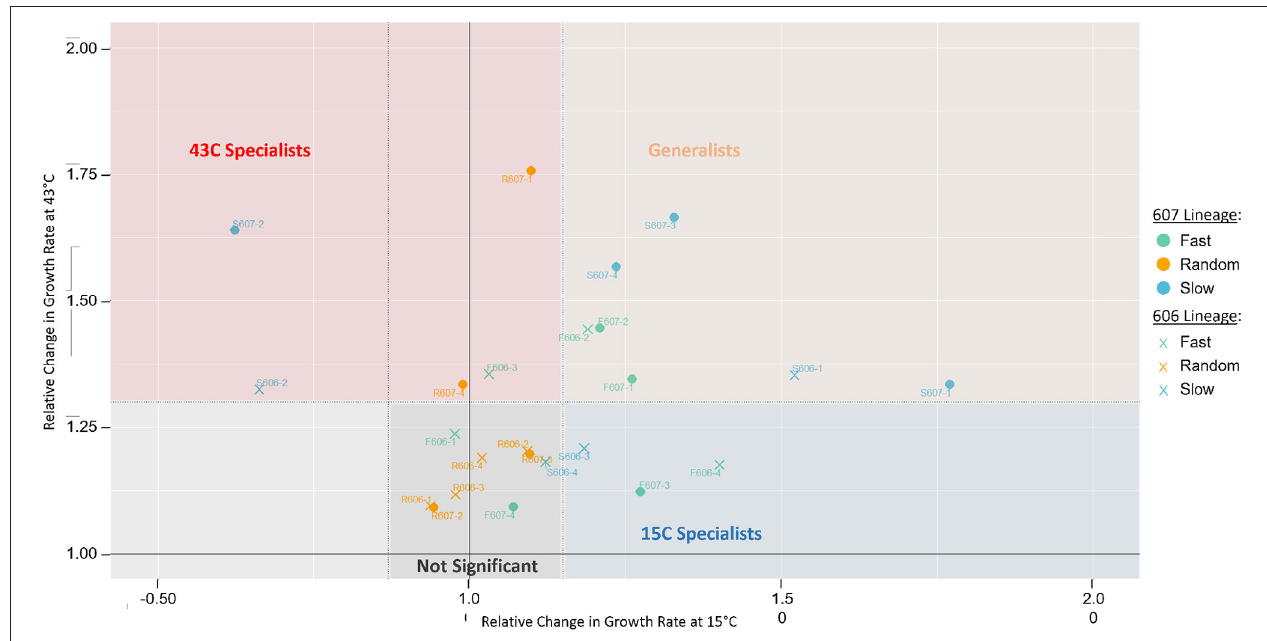
FIGURE 2 | Growth rate changes of isolated clones from the final populations relative to their starting strain, 606P or 607P. The y-axis represents the relative change in growth rates of the evolved clones compared to their respective starting strain at 43 ◦ C. The x-axis represents the relative change in growth rates at 15 ◦ C. For each temperature, statistical significance between the clonal strains and their corresponding reference strain was assessed by a two-sample T -test with a pooled sample variance using all the strains at the same temperature. The dotted lines represent the statistically significant cut-offs, such that points falling outside the dotted lines have a p -value < 0.05. For these statistically significant strains, we classify them as either generalists or specialists. Namely, a clone is classified as a “generalist” if relative growth statistically significantly increased at both 15 and 43 ◦ C (in peach), classified as “43 ◦ C specialist” or “15C specialist” if relative growth increased in only 43 ◦ C (in red) or 15 ◦ C (in blue), respectively, and classified as “not significant” if relative growth did not increase in either temperature (in gray). Using a Fisher Exact Test, we find classification of generalist strains is significantly enriched in the slow and fast periodic strains compared to the random strains ( p -value = 0.054). There is no significant environmental fluctuation treatment effect for specialists observed (periodic vs. random strains, p -value = 0.67). In support of periodic strains being more likely to be generalists, the periodic strains also have significant increased relative growth rate variation in both 15 and 43 ◦ C, suggesting periodic strains have a greater capacity to adapt to both temperatures. Whereas, the random strains have only increased variation at 43 ◦ C but not at 15 ◦ C. Using the F-statistic, we find periodic strains variance is significantly increased to that of the random strains at 15 ◦ C ( p -value = 0.001).